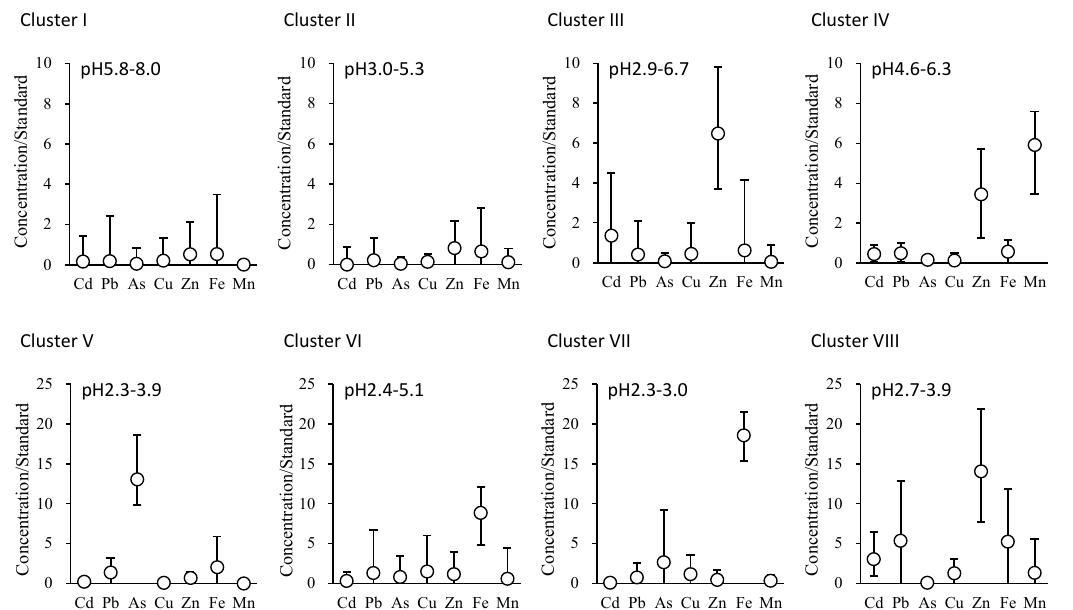
Figure 4. The ratio of the metal concentration to the e ffl uent standard (Cd 0.03 mg/L, Pb 0.1 mg/L, As 0.1 mg/L, Cu 3 mg/L, Zn 2 mg/L, soluble Fe 10 mg/L, and soluble Mn 10 mg/L) in Clusters I–VIII of mine drainage in Japan (2014–2016) (Figure 3). Average plots and bars for maximum and mini- mum values are displayed in detail.